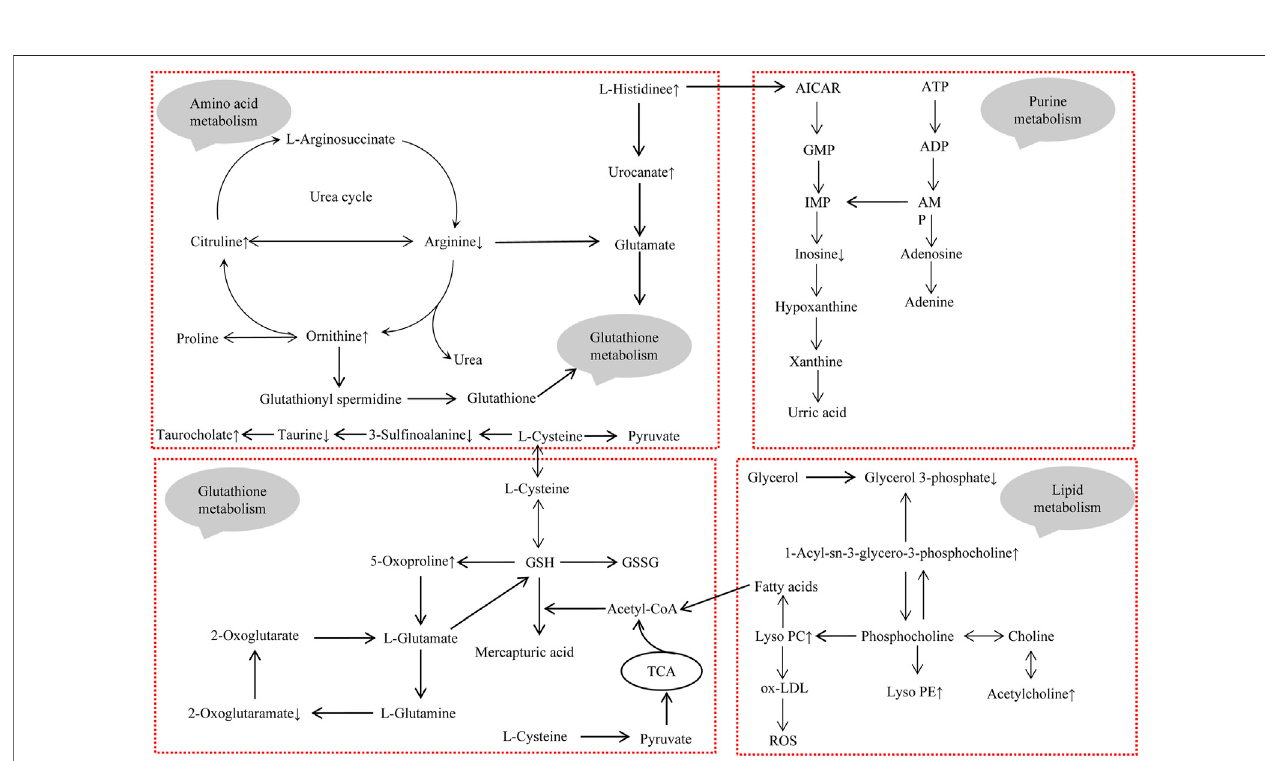
FIGURE 7 | The integrated metabolic pathway related to Realgar-induced acute kidney injury. Upward arrows indicate elevated levels after exposure to Realgar, and conversely, downward arrows indicate decreased levels after exposure to Realgar.